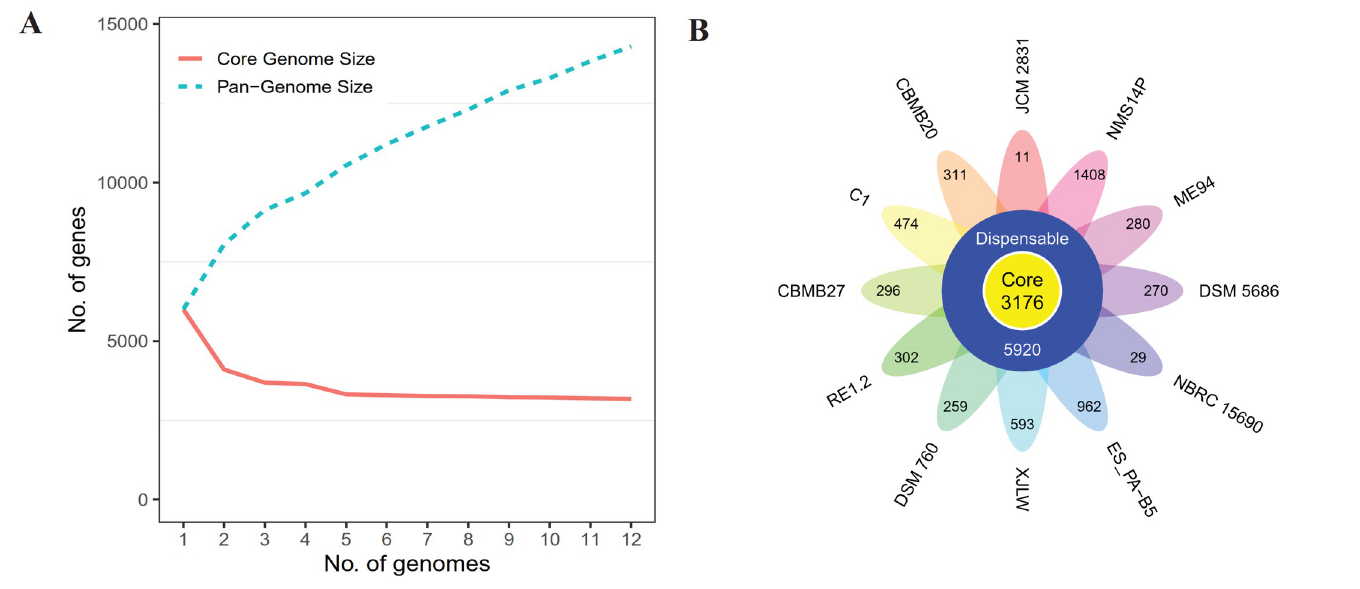
Fig 6. Core and pangenome analysis of NMS14P. (A) The number of core and pangenome sizes as a function of the number of genomes added. (B) Flower plot representing the number of core and strain-specific genes of Methylobacterium species based on clusters of orthologous groups.